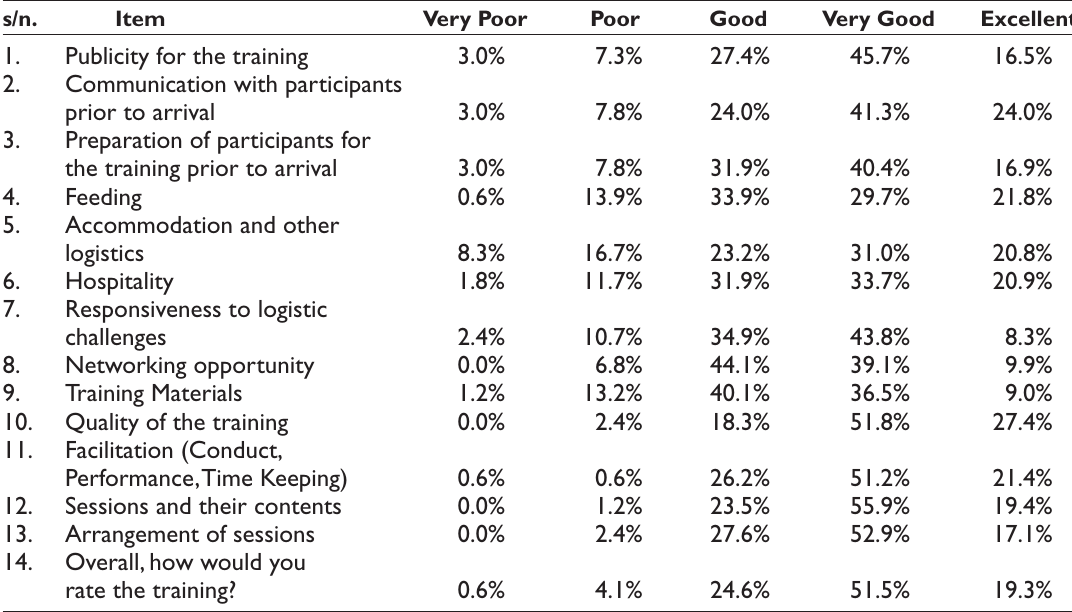
Evaluation of the training by the